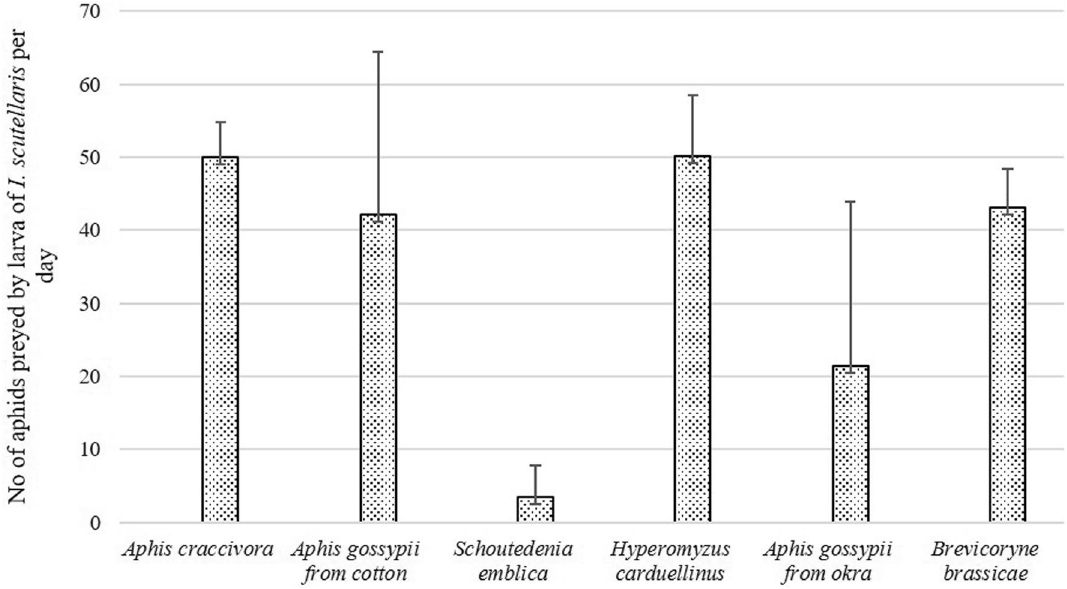
Fig. 1 Feeding potential of the larva of Ischiodon scutellaris on different aphid hosts. Note: Among all the species of aphids studied, Aphis fabae was not accepted by the syrphid, I. scutellaris hence not included for statistical analysis